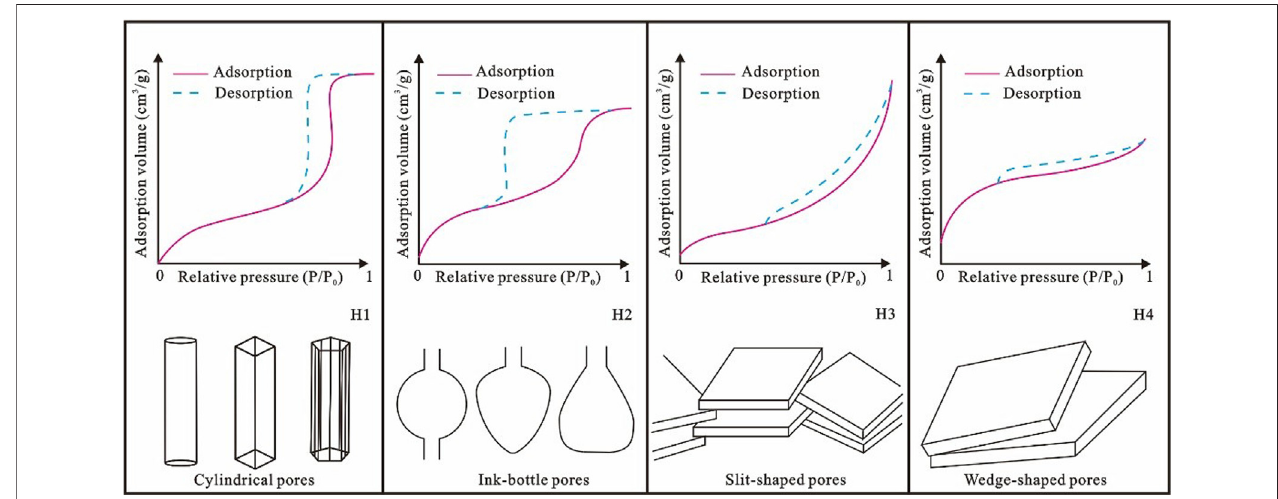
FIGURE 2 | Four patterns of hysteresis loops and their corresponding pore shapes (modi fi ed from Sing et al., 1985).